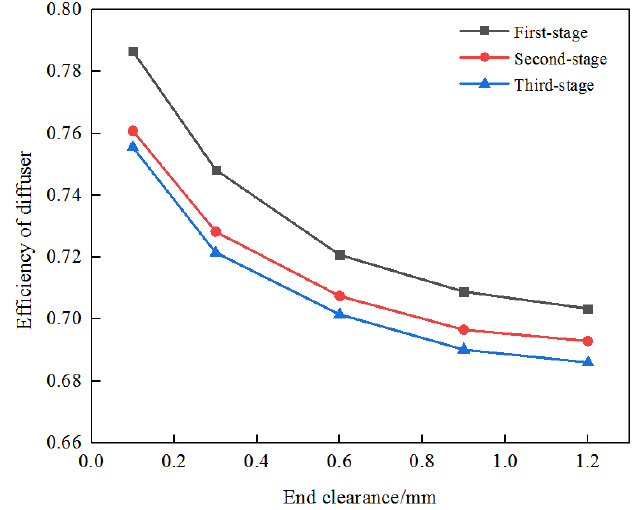
Figure 14. Comparison of the efficiency of the diffuser at different end clearances.